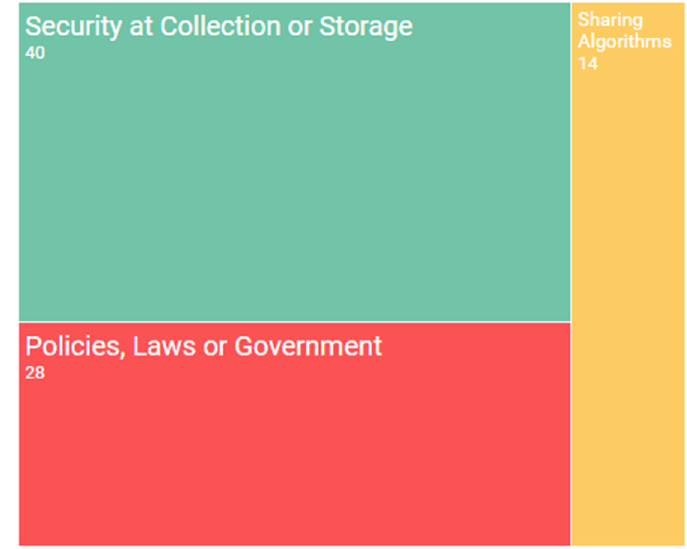
Figure 5. Main topics on data management.